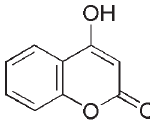
FIGURE 1 - Structure of